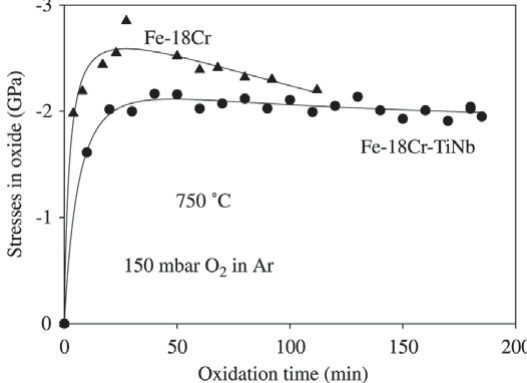
Figure 3. Oxide growth stresses at 750 °C measured by in situ Raman spectroscopy during oxidation in oxygen of the reference and bi-stabilised stainless steel grades.